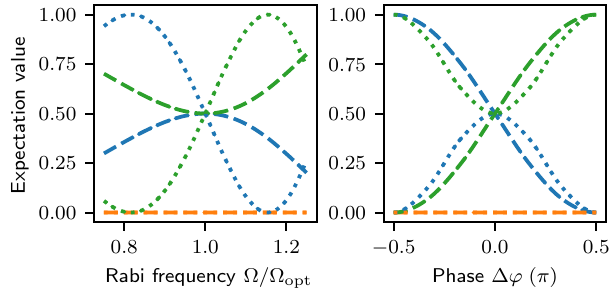
FIG. 6. Expected outcome probabilities of P ( | g , g (cid:3) ) (green), P ( | e , e (cid:3) ) (blue), and P ( | e , g (cid:3) ) + P ( | g , e (cid:3) ) (orange) (π/ 2 ) gate sequence (dotted) and for a for a 3 U 0 MS (π/ 2 ) U π/ 4 (π/ 2 ) sequence (dashed). The first gate U 0 MS MS sequence is first-order insensitive to phase miscalibrations as the local minimum of the outcome probabilities around zero leads to only small variations in the likelihood of possible outcomes, and its symmetry around zero does not allow one to discriminate the sign of the miscalibration. Similar arguments can be used to see that this sequence is first-order sensitive to Rabi frequency miscalibrations. For the second gate sequence, the relation is inverted, being sensitive to phase miscalibrations at the cost of first-order insensitivity to the Rabi frequency. The qualitative behavior of the sensitivity of the center line matches the sensitivity of the phase difference, while the behavior of the sideband detuning matches the Rabi